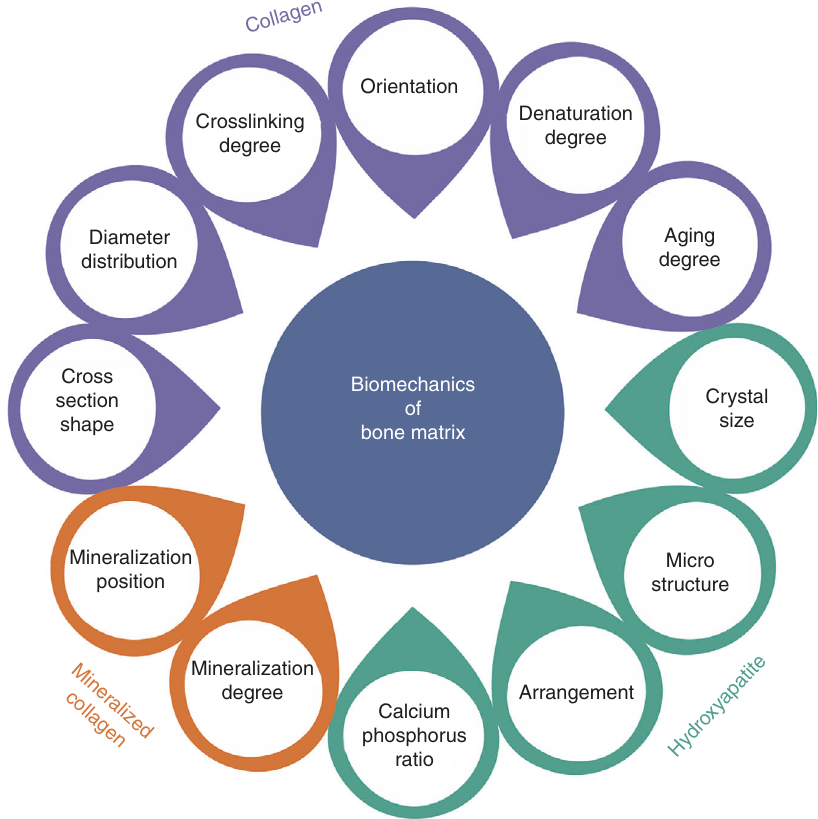
Fig. 3 Component factors affecting bone-matrix